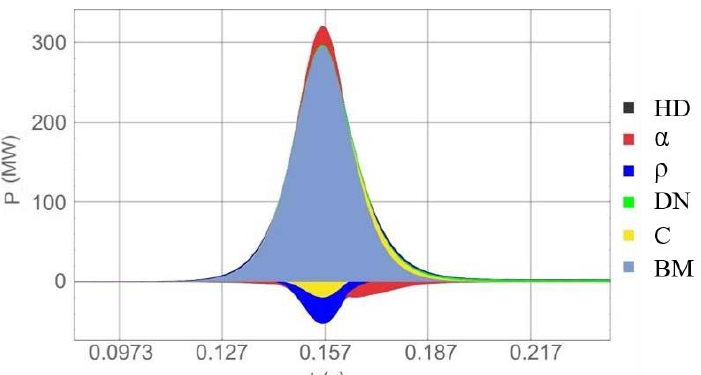
Figure 3: Individual contributions of improvements of IPM for 2 $ inserted reactivity. All maxima power displaced to the same